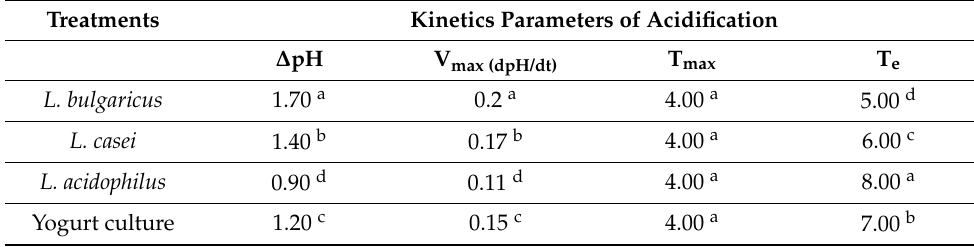
Table 1. Kinetics parameters of acidification through fermentation of rice milk by the three lactic acid strains and the commercial yogurt culture.